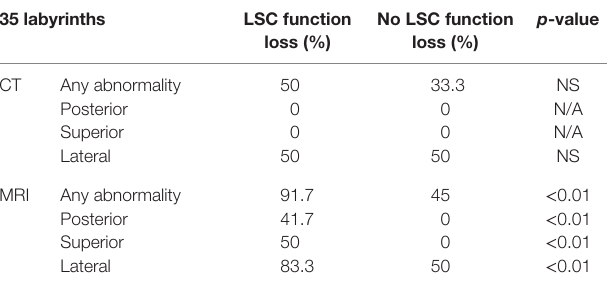
TaBle 2 | correlation between lateral semicircular canal function loss and imaging abnormalities on the left